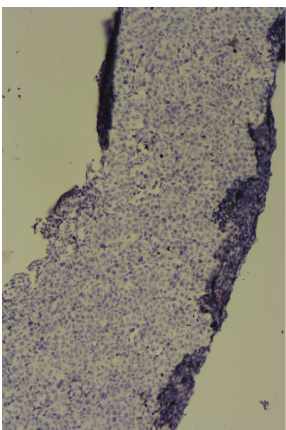
Figure 9: Adrenal biopsy immunohistochemical staining showing negative CD10 expression.